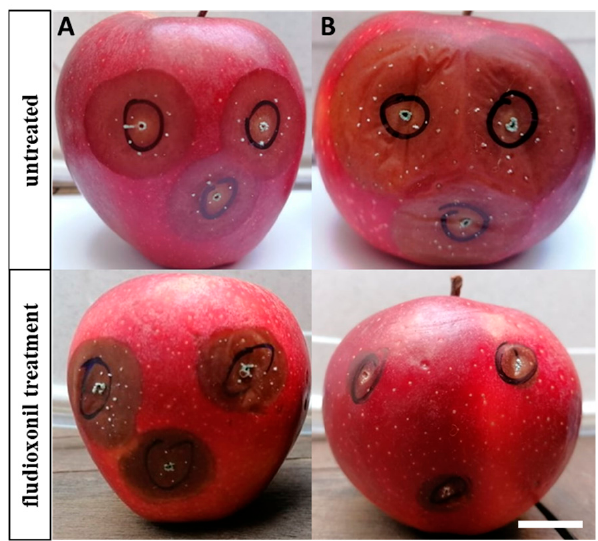
Figure 1. Apple fruit (cv. Red Delicious) artificially inoculated with ( A ) a fungicide-resistant; and ( B ) a sensitive strain of P. expansum in the absence (up) and in the presence (down) of fludioxonil (scale bar: 1 cm).